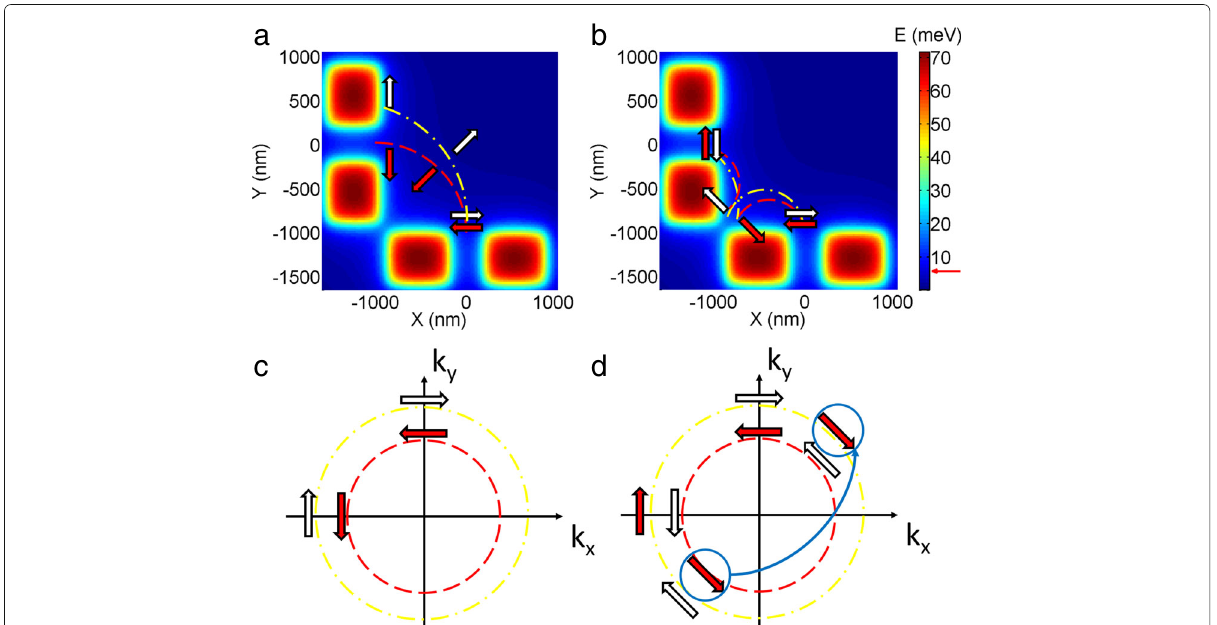
Fig. 2 Mechanism of peak splitting. a , b Peak splitting in the coordinate space for first and second focusing peaks, respectively. The red and white arrows represent spin-up and spin-down electrons, the coloured blocks stand for the electrostatic potential and the red-dashed trace is with smaller cyclotron radius while the yellow-dotted one is with larger cyclotron radius. c , d Peak splitting in the k-space for the first and second focusing peaks, respectively. The electrons travel from (0, k y ) to (-k x , 0) anticlockwise in plot ( c ). In plot ( d ), the thick blue arrow highlights the transition after reflection at the boundary of electrostatic potential formed between the injector and